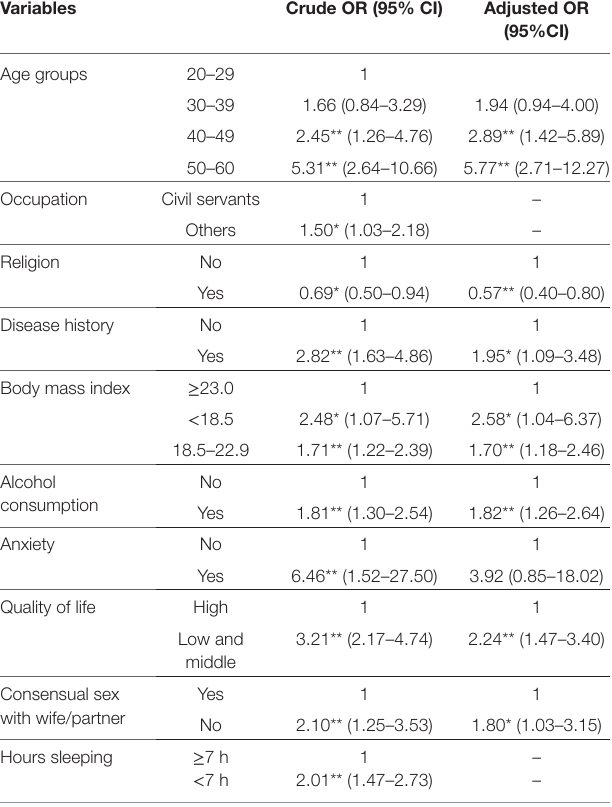
TaBle 3 | Multivariate logistic regression model.